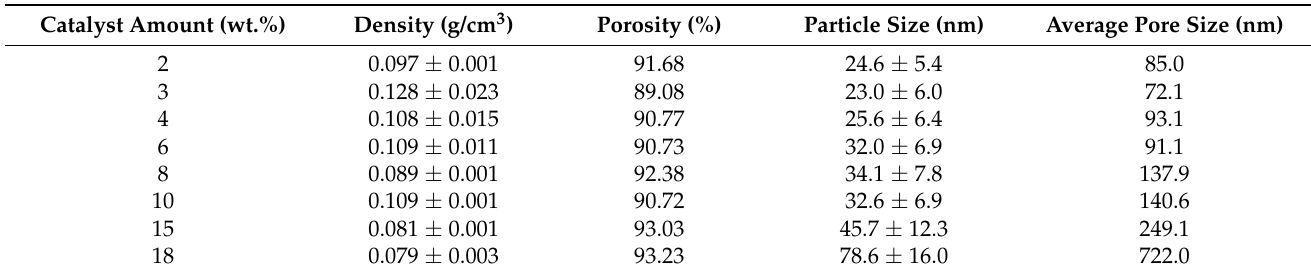
Table 1. Structural parameters describing the aerogel